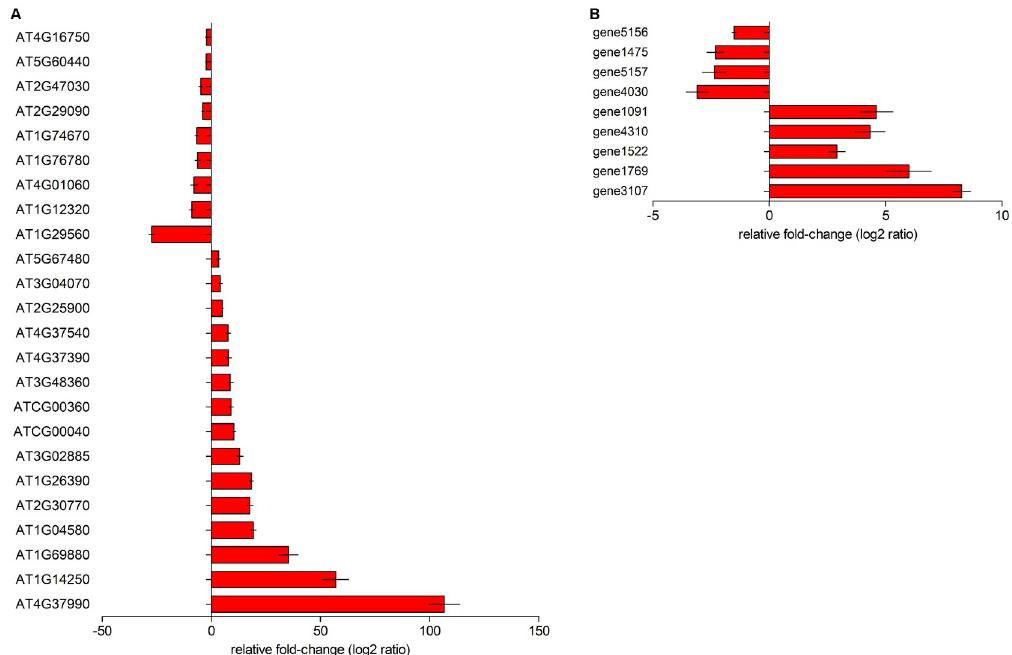
Fig 7. Analysis of differential expressed genes using qRT-PCR. A) Expression levels of Arabidopsis plants genes during the interaction with B . aryabhattai . B) Expression of bacterium genes in planta .